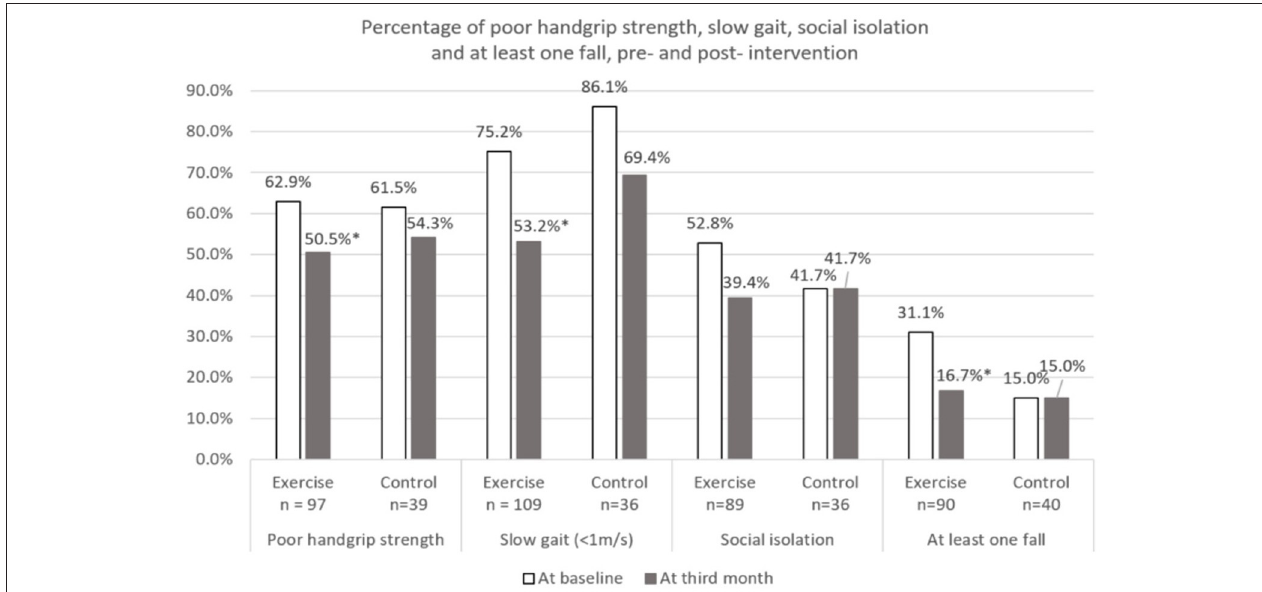
FIGURE 5 | Percentage of poor physical performance, social isolation, and at least one fall at baseline and third month. *Indicates significant difference at p < 0.05 between baseline and third month using McNemar test. Poor handgrip strength defined using Asian Working Group for Sarcopenia (2019) (Cut-off: Male < 28kg and